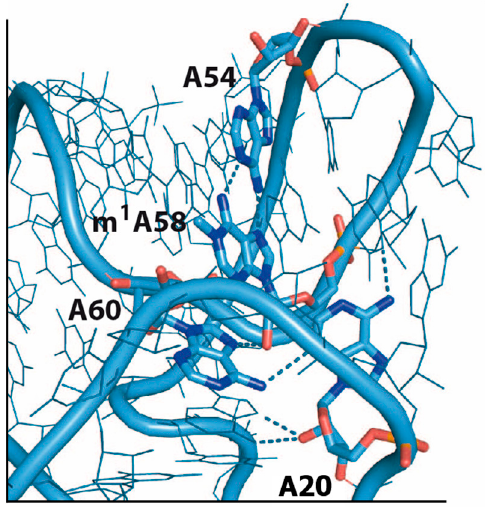
Figure 2. An overview of the ‘corner’ of the L-shaped initiator tRNA (tRNAi) from eukaryotes (PDB 1YFG). The nucleobases A20, A54, and A60 are highlighted along with the N1-modified A58 (m 1 A58). Hydrogen bonds are drawn as dotted lines.